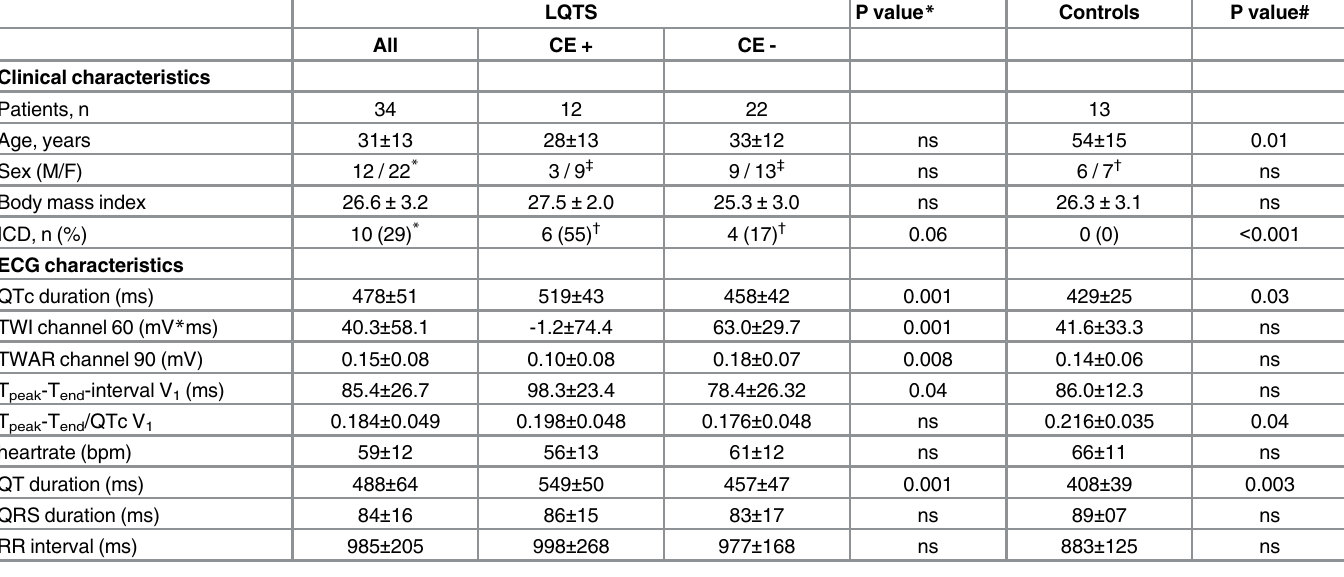
Table 1. Clinical and electrocardiographic characteristics of study patients. CE clinical event; F female; ICD implantable cardioverter defibrillator; LQTS long-QT syndrome; M male; n number; ns not significant; TWAR T-wave amplitude range; TWI T-wave integral. Values are expressed as mean ± SD where